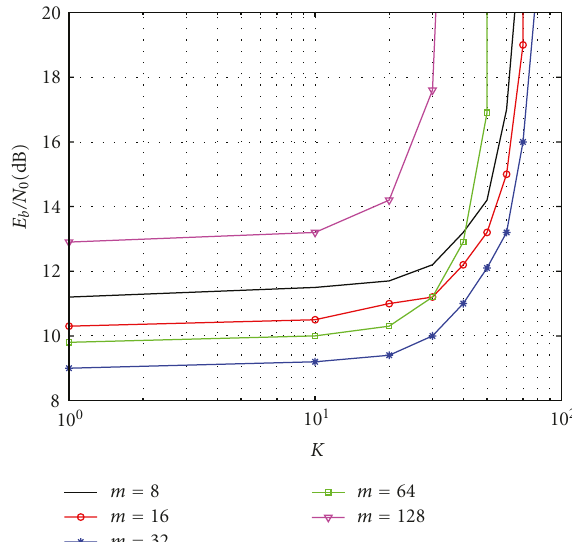
Figure 9: SNR required for a convolutionally coded FHSS system achieve P b = 10 − 4 over Rayleigh fading versus the number of users K with an OPE receiver for SIR = 5dB and m = 8,16,32,64,128.